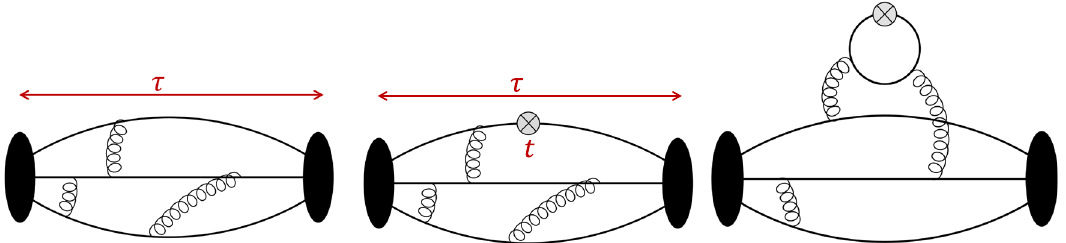
Fig. 42 The two- and three-point correlation functions (illustrated by Feynman diagrams) that need to be calculated to extract the ground state nucleon matrix elements. (Left) the nucleon two-point function. (Middle) the connected three-point function with source-sink separation τ and operator insertion time slice t . (Right) the disconnected three-point function with operator insertion at